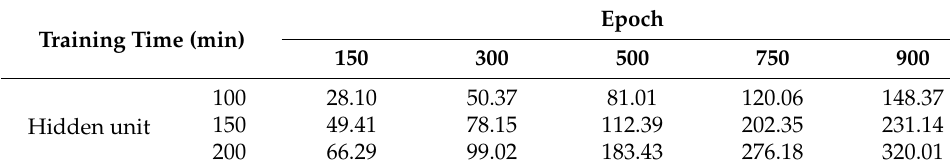
Table 3. Training time according to numbers of epochs and hidden units.